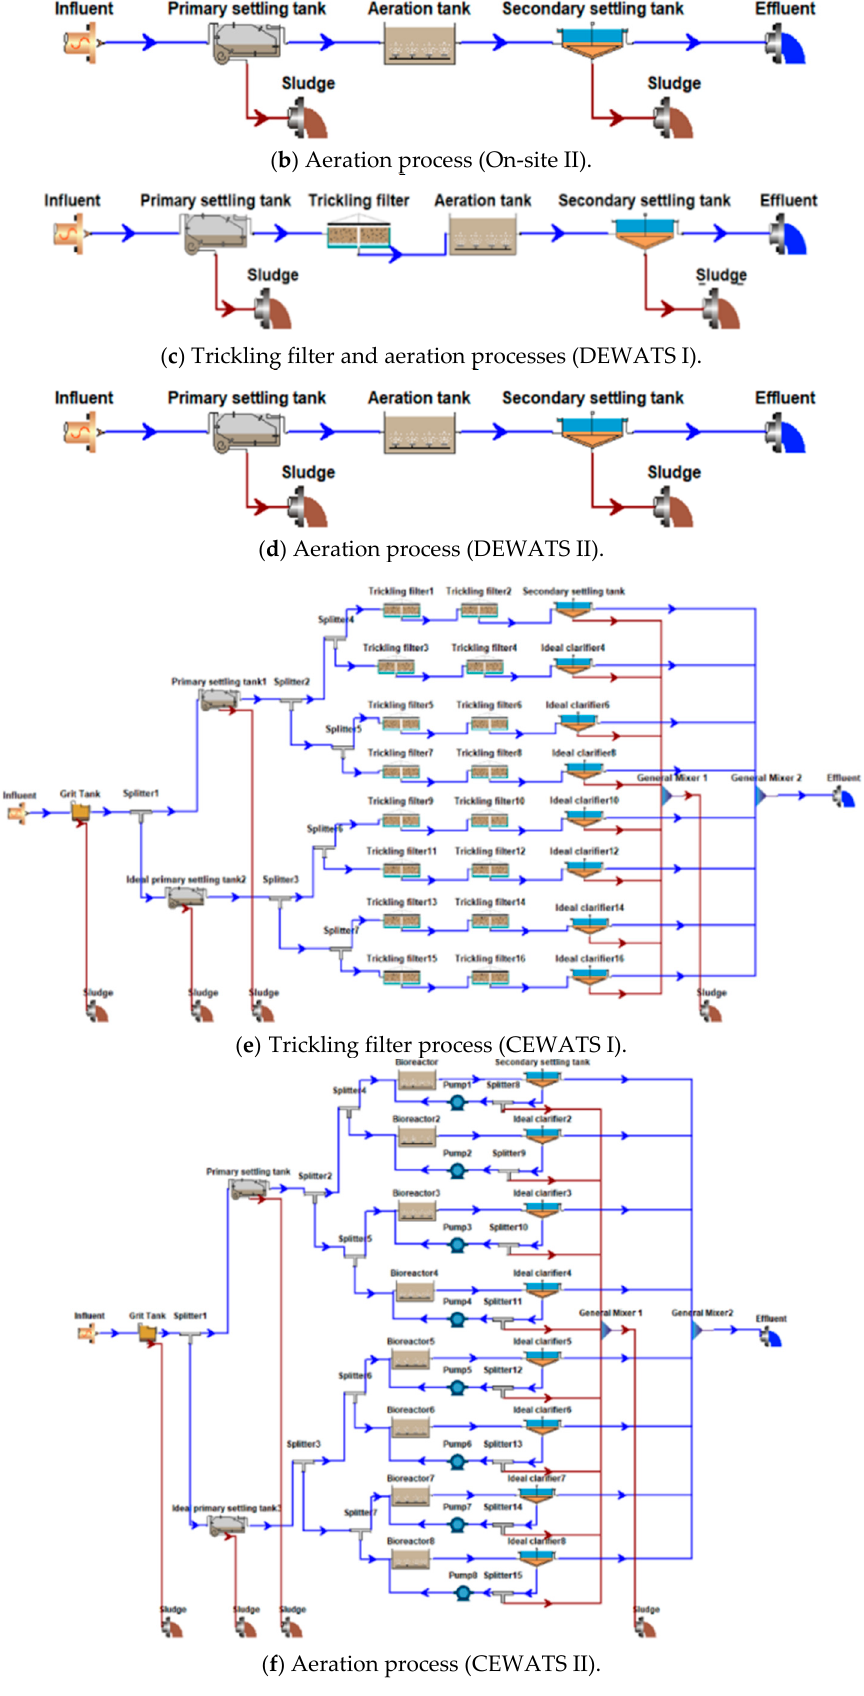
Figure 4. Six wastewater treatment models considered in the BioWin simulations.